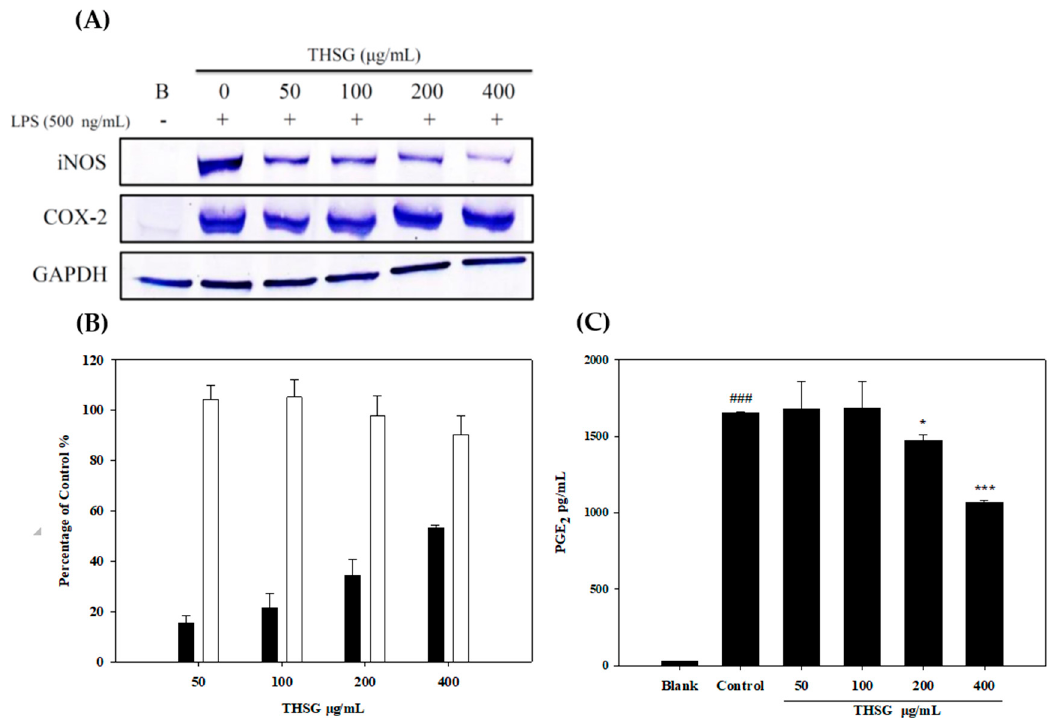
Figure 4. Anti-inflammatory of 2,3,5,4 ′ -Tetrahydroxy-stilbene-2- O - β - D -glucoside (THSG) on lipopolysaccharide (LPS)-stimulated RAW 264.7 cells after treatment for 6 h. iNOS and COX-2 protein expressions ( A ); NO production inhibition rate of THSG and ☐ cell viability ( B ); PGE 2 production level ( C ), #: control group as compared to blank group, ### p < 0.005. *: TSHG group compared to control group, * p < 0.05, *** p < 0.005.